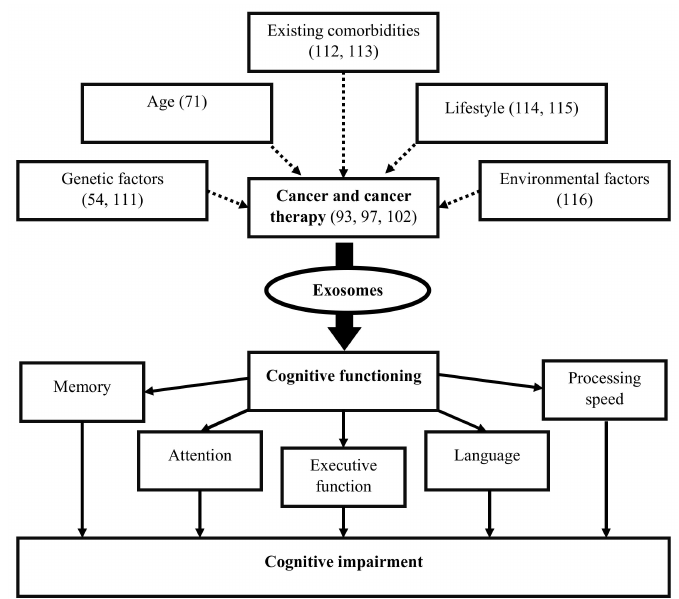
Figure 2. Exosomes release as a result of cancer and cancer therapy may alter cognitive functions, resulting in cognitive impairment in cancer survivors. Genetics, age, existing comorbidities, lifestyle, and environmental factors predisposed to (dotted lines) cancer and cancer therapy may a ff ect exosome biogenesis, its cargo content, function, and activity to influence cognitive functioning including memory, attention, executive function, language, and processing speed.